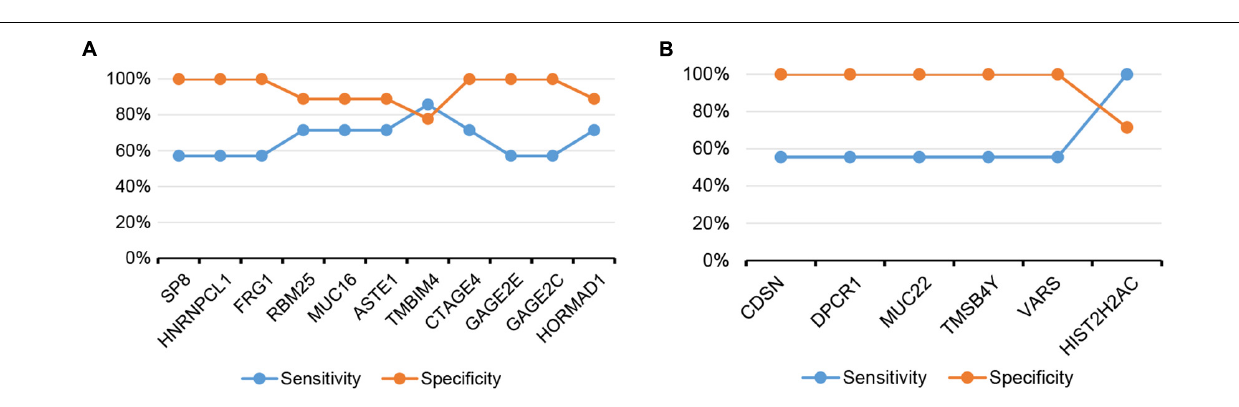
FIGURE 5 | The sensitivity and specificity of assessing dicycloplatin response using the mutation or CNV status of single gene. (A) Dicycloplatin resistance and (B) dicycloplatin